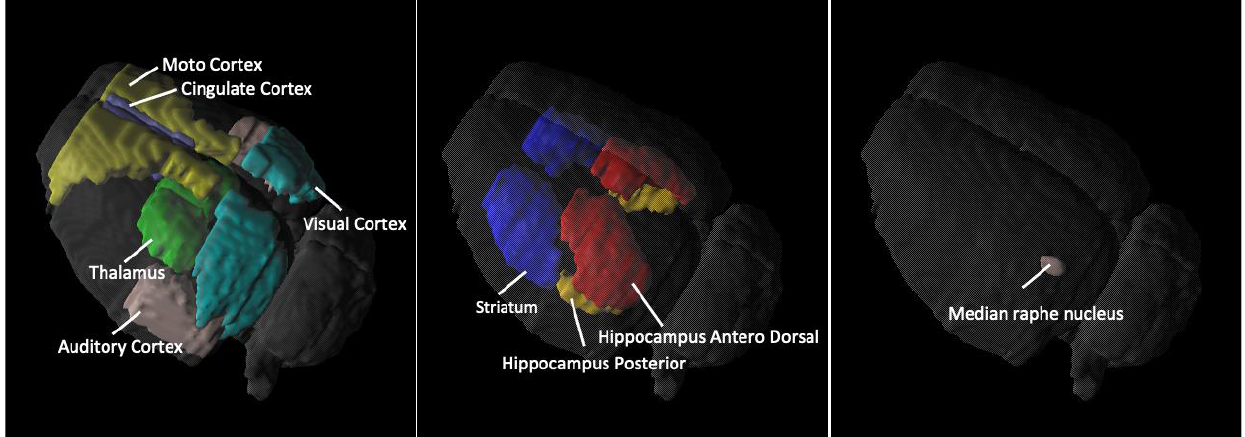
Figure 1. 3D 4-[18F]-ADAM PET images Illustration of 9 brain areas of interest (ROIs) used to estimate SERT binding of 4-[18F]-ADAM.